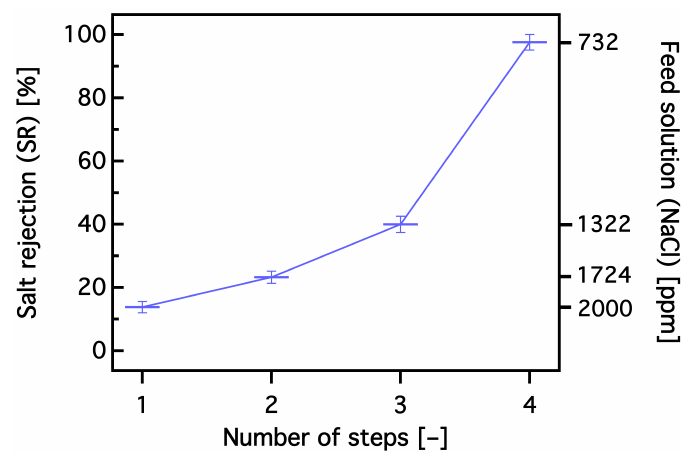
Figure 16. Total number of steps required to achieve a complete salt rejection ( SR ) using GG10k–30 hydrogel. The straight line is a guide for the eye.